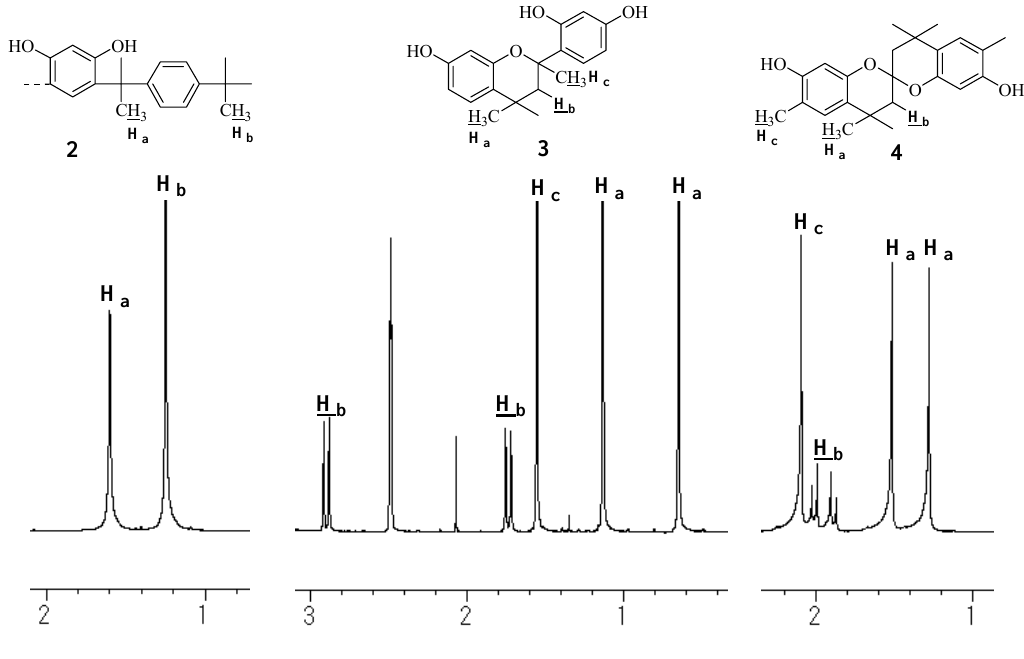
Figure 9 . 1 H-NMR spectra of 2 , 3 (DMSO, 400 MHz), and 4 (MeOH, 400 MHz).